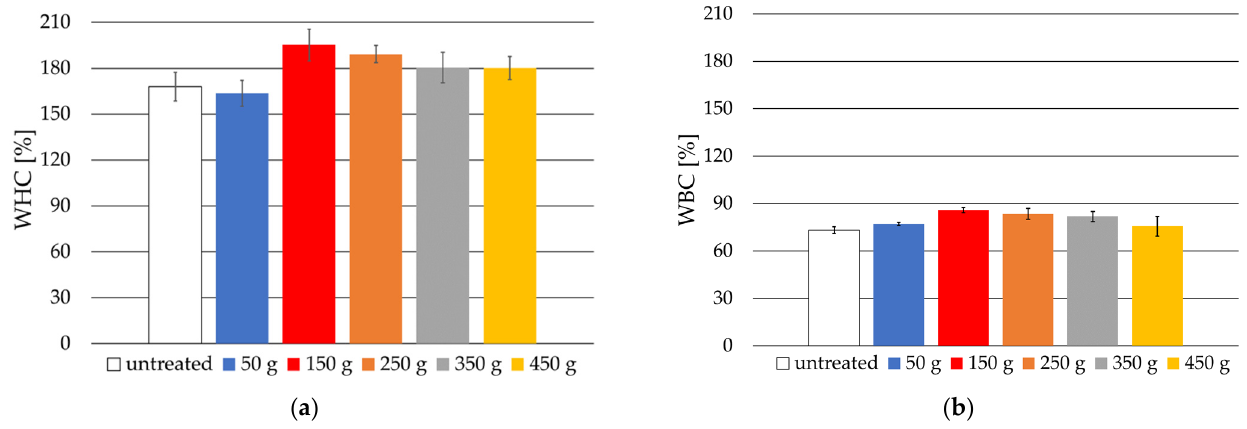
Figure 7. Effects of reactor filling on the WHC ( a ) and WBC ( b ) values of untreated and NTP-treated flour (type 550; treatment time: 3 min).